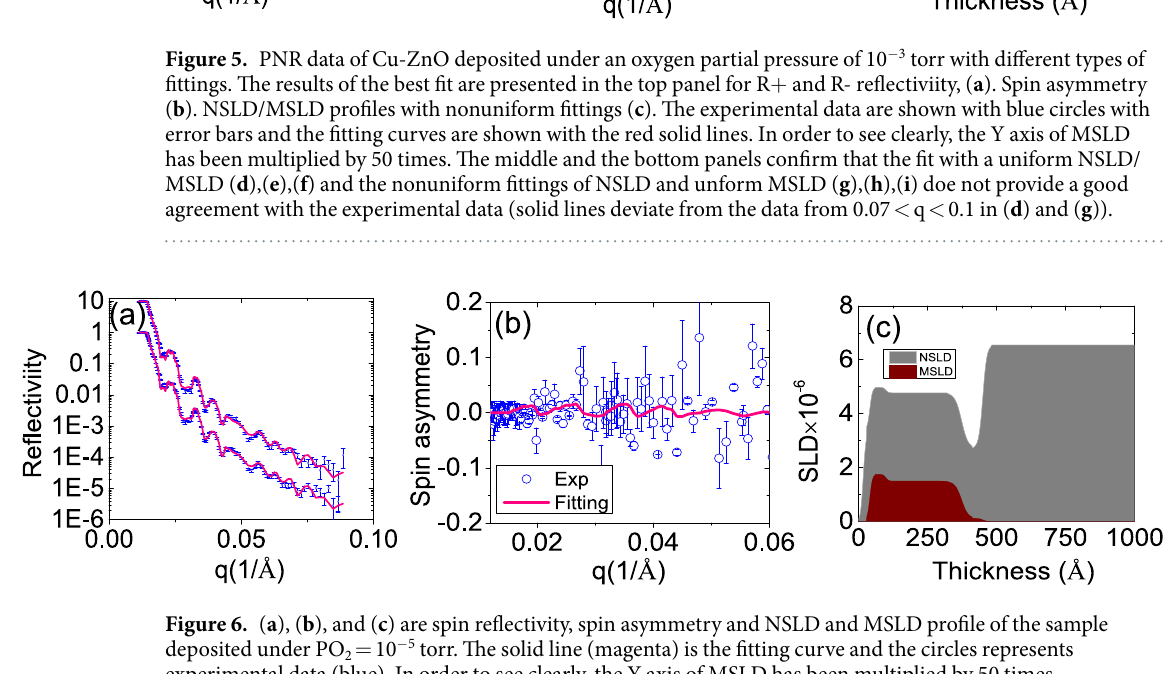
magnetization on the surface since for PO 2 = 10 − 5 sample, Ti also is high in the interface, while PNR analysis did not show enhanced magnetization in the interface of this sample, supporting that Cu concentration contributes to the enhanced magnetization.